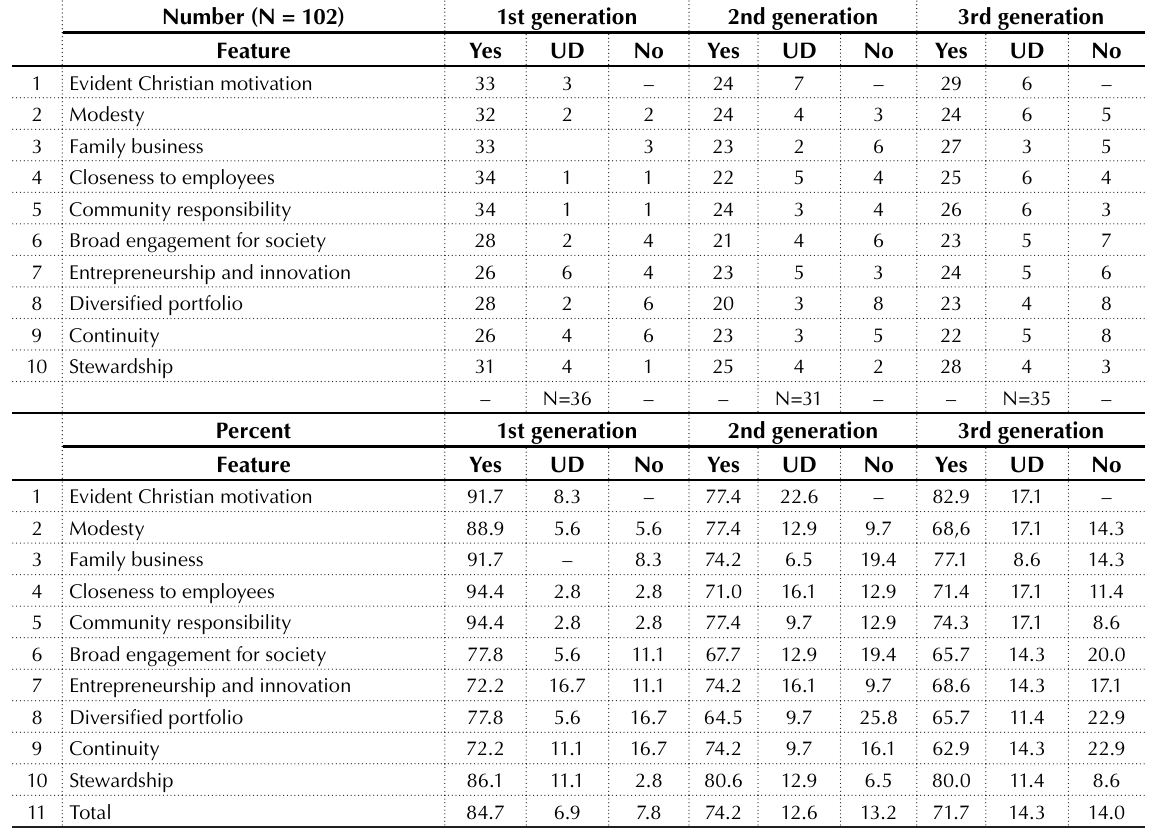
Table 4. Common attributes in Haugean